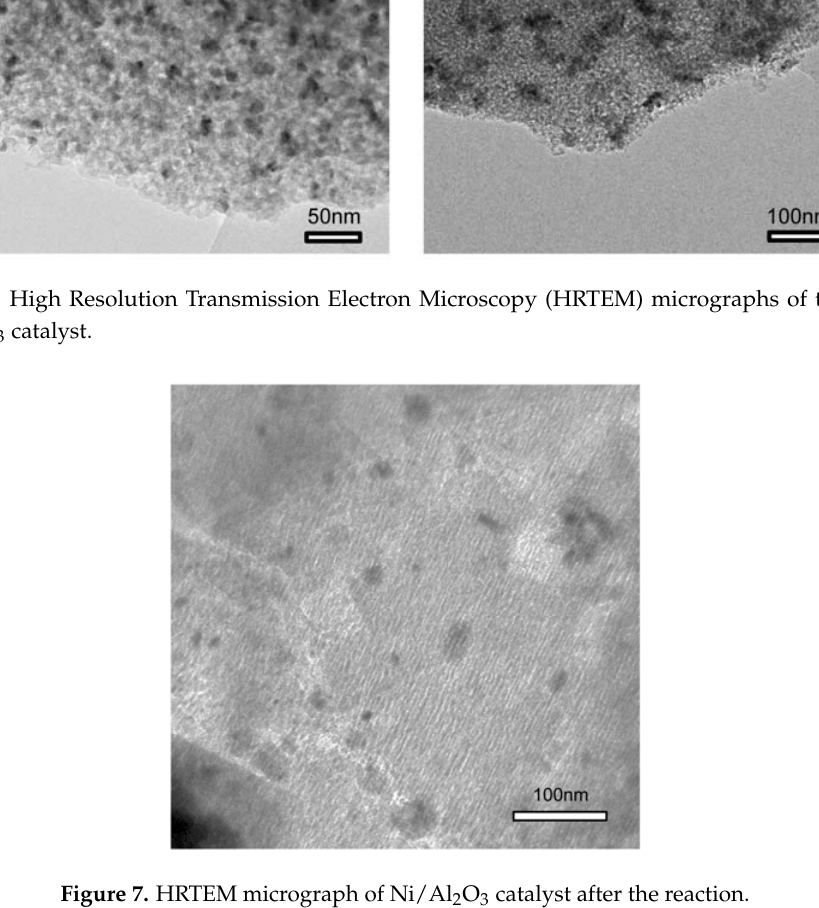
Figure 7. HRTEM micrograph of Ni/Al 2 O 3 catalyst after the reaction.